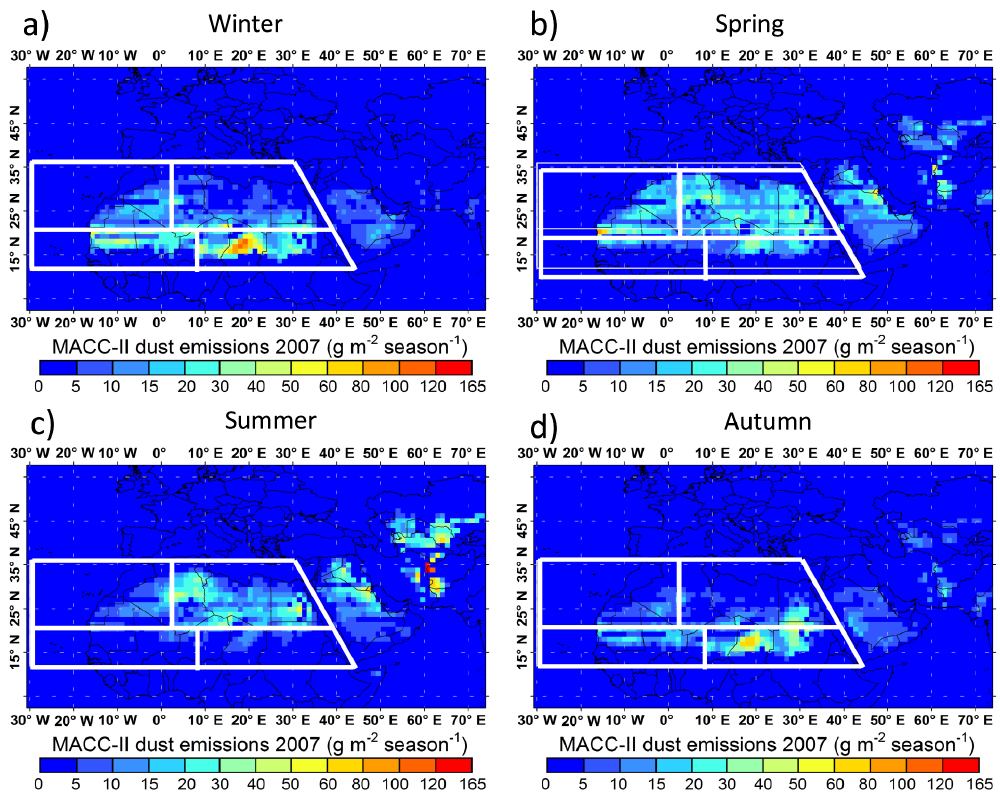
Figure 1. Accumulated daily dust emissions from MACC-II for winter (JFM), spring (AMJ), summer (JAS) and autumn (OND) 2007 (gm − 2 season − 1 ). The contours of the four Sahara–Sahel sub-regions regions are marked with white